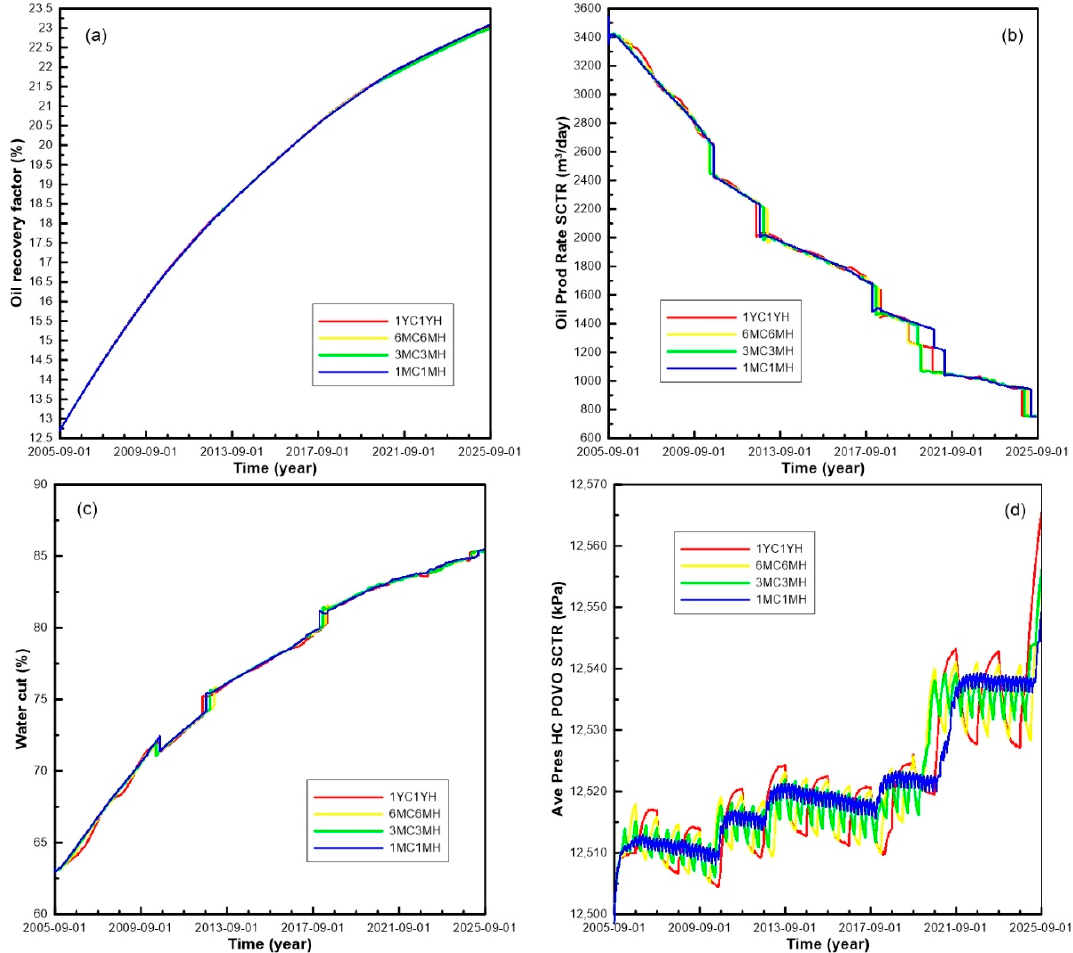
Figure 7. Simulated result curves of oil recovery factor ( a ), oil production rate ( b ), water cut ( c ) and average reservoir pressure ( d ) of during the CO 2 flooding with a same WAG ratio of 1:1 but different length of slug sizes.